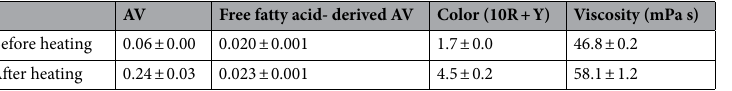
Table 1. Changes in AV, free fatty acid-derived AV, color, and viscosity by the heating of canola oil. Mean ± SD. Fresh canola oil was placed in a stainless steel dish and heated on a digital heat block at 180 °C for 6 h (N =